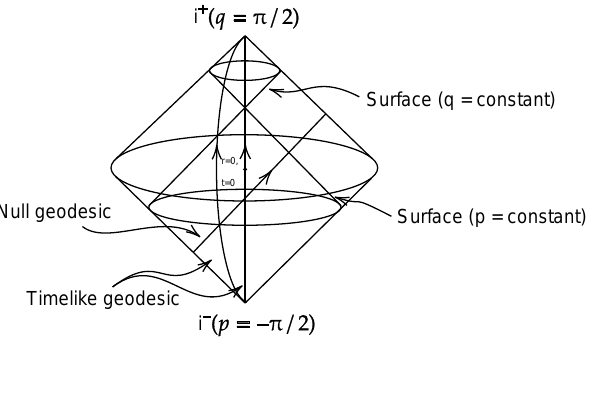
Figure 1: A plot of the ( t (cid:48) , r (cid:48) , φ ) coordinates of 3-dimensional flat space. The r (cid:48) coordinate is plotted radially, but it should be understood that the metric in the radial direction is not flat becaause of the conformal transformation. All points on the circle drawn at r (cid:48) = π are identified, and becomes the point at infinity. Our figure should be compared to figure 15 (i) in Hawking&Ellis. But we believe that what is labeled as a spacelike geodesic in the figure there is only a spacelike curve , at least for the 2 + 1 dimensional case that we consider here. We will have more to say about spacelike geodesics in this